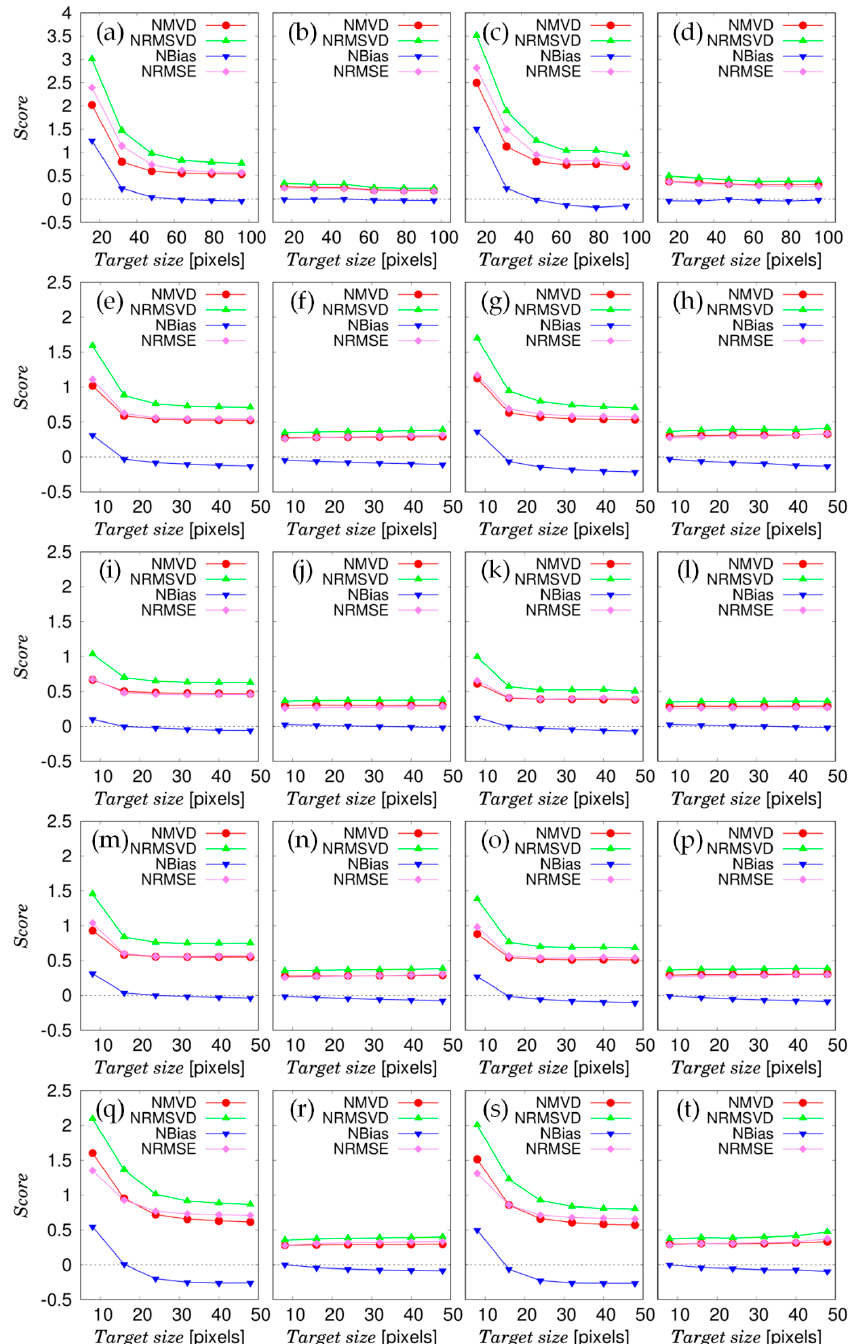
Figure 5. Plots of validation scores of normalized MVD (NMVD), normalized RMSVD (NRMSVD), normalized Bias (NBias), and normalized RMSE (NRMSE) versus the target box size for cloudy AMVs for CH03, 07, 08, and 13 and clear-air AMVs for CH08 for July 2016. All scores were normalized by the speed of the corresponding reference vectors. GK-2A AMVs for CH03 compared with GDAPS are shown for ( a ) nonzero QIF and ( b ) QIF > 80; those compared with rawinsonde are shown in ( c ) and ( d ), respectively. The same types of plots were used for cloudy AMVs for ( e – h ) CH07, ( i – l ) CH08, and ( m – p ) CH13 and for clear-air AMVs for ( q – t ) CH08. All validation scores were best at 48 × 48 for CH03 and at 16 × 16 for the other channels. Their NRMSE, NMVD, and NRMSVD became smaller than 0.5 after quality control with AMVs of QIF > 80, compared with GDAPS and rawinsonde. The results obtained for January 2017 were